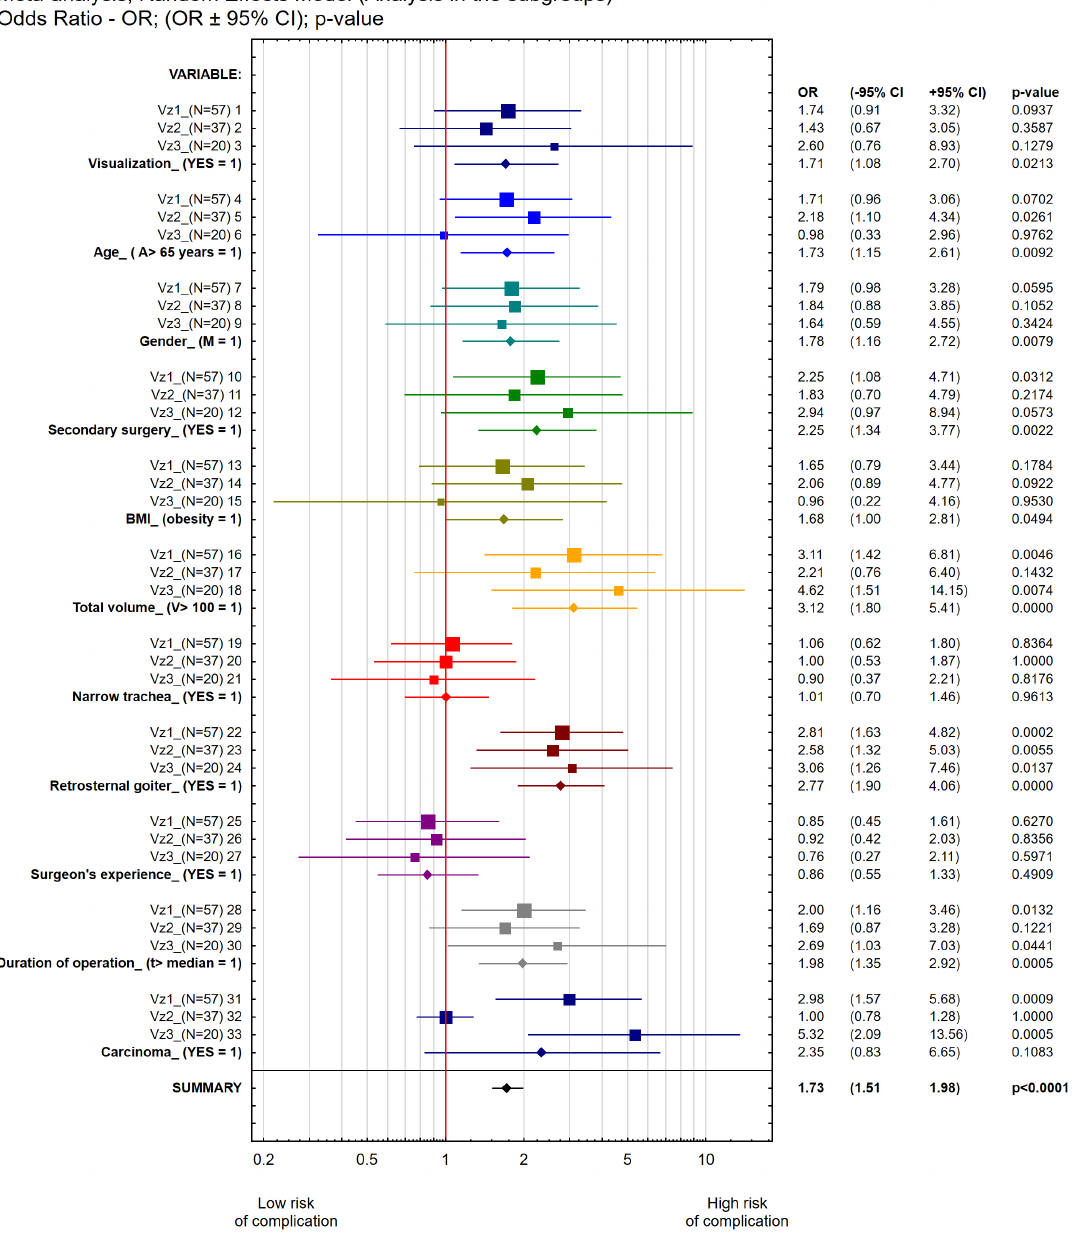
Figure 2. Meta-analysis of variable effects according to a scheme that takes into account all the possible interactions among the selected